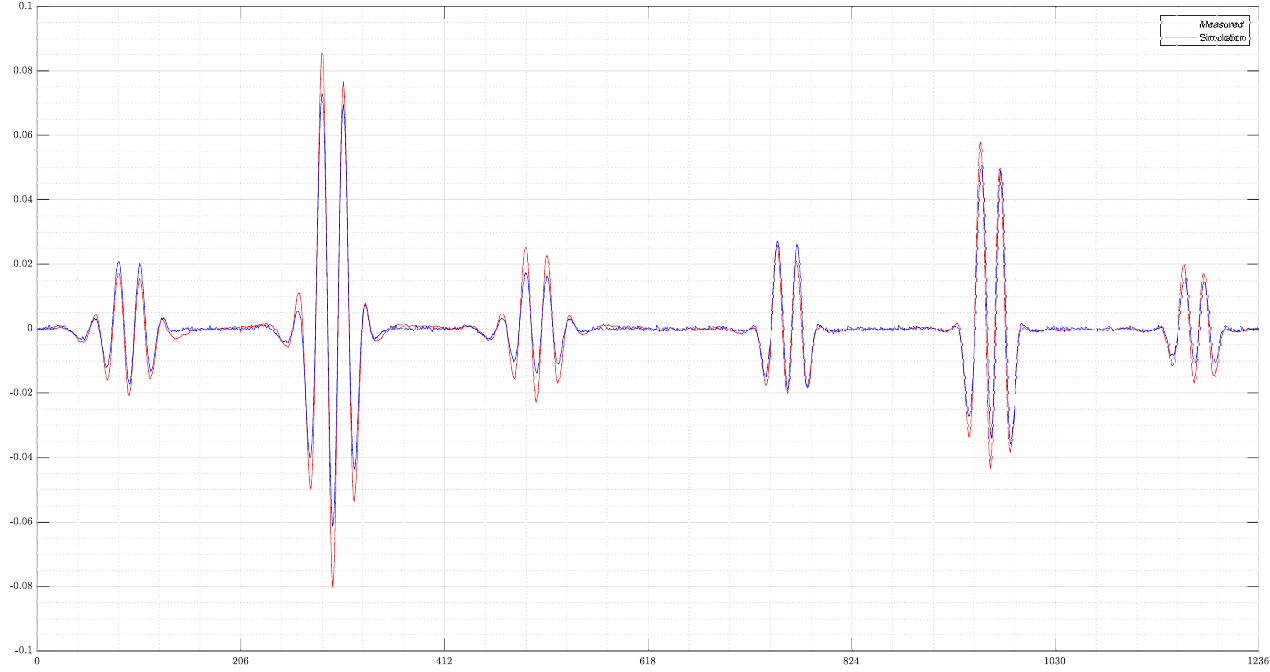
Figure 10. Comparison of the measured and simulated differential signals. The measured differential signal of the real MIT setup shows higher amplitudes than the simulated signal. However, the pattern of the signal is very close to the simulated